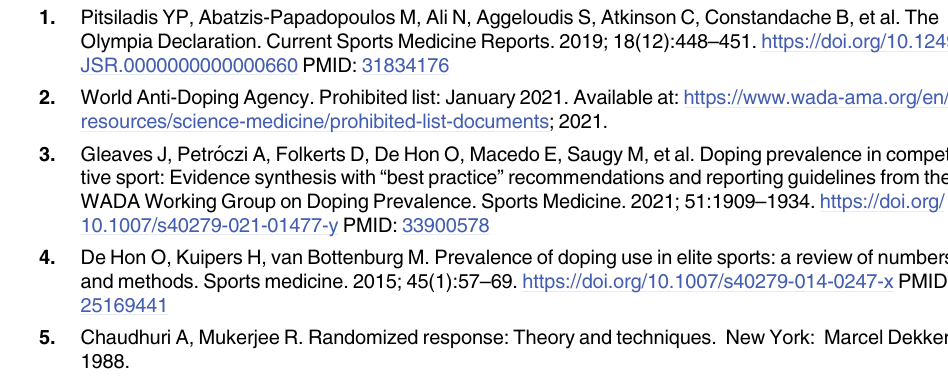
S1 Table. Summary of the project design in Studies I, II and